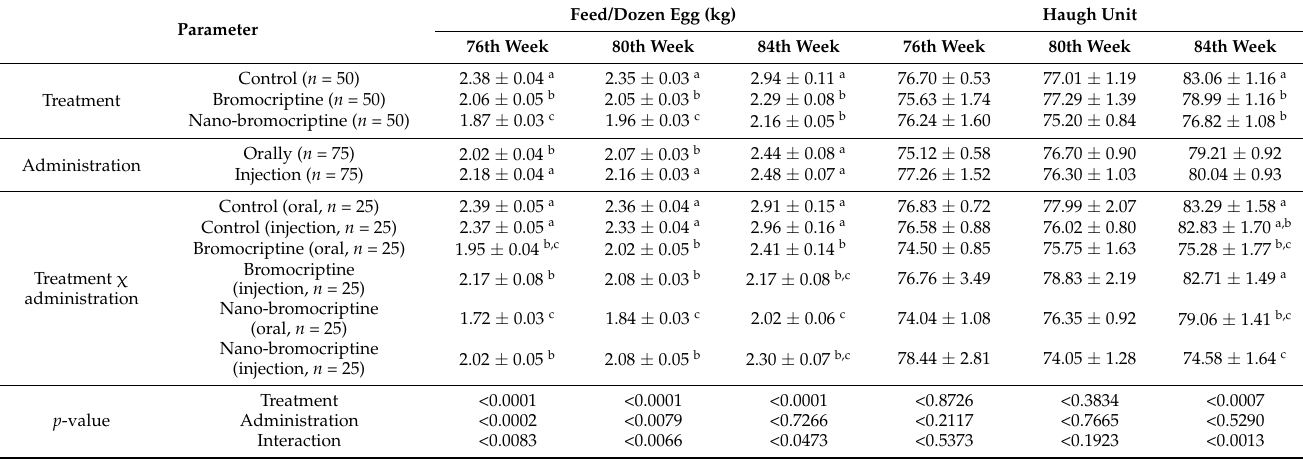
Table 2. Effects of bromocriptine and nano-bromocriptine on feed consumption per dozen egg and Haugh unit of late laying